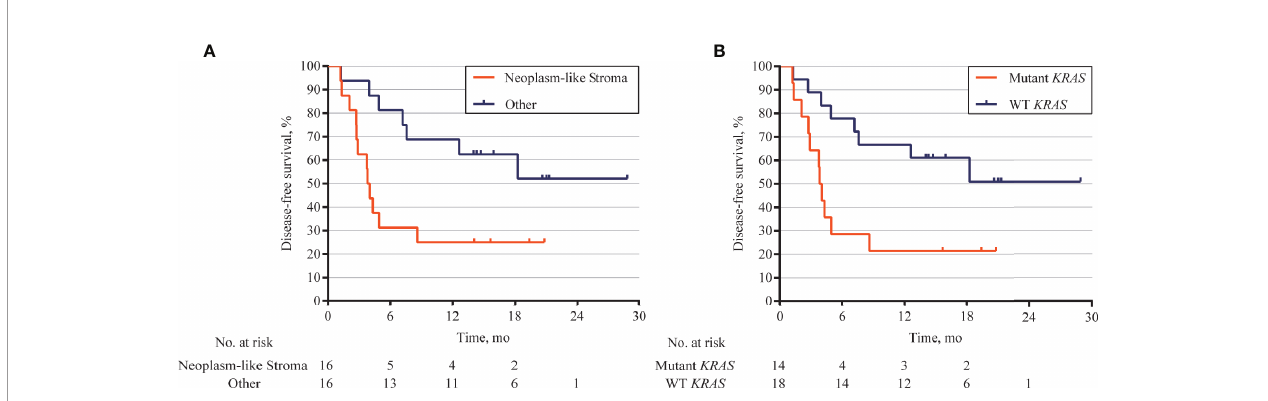
FIGURE 6 | Kaplan – Meier curves for disease-free survival (DFS) according to genomic status of stroma. (A) DFS analysis in 32 patients followed up over 1 year after surgical operation. Patients with neoplasm-like stroma had markedly short DFS (median = 3.9 months) than those without neoplasm-like stroma (median DFS unreached, hazard ratio = 3.079, 95% CI 1.126 to 7.215, p = 0.0193). (B) Patients with KRAS -mutant stroma also showed poor DFS (median = 3.9 months) than those with KRAS -wild-type stroma (median DFS unreached, hazard ratio = 3.304, 95% CI 1.247 to 8.751, p = 0.0162).